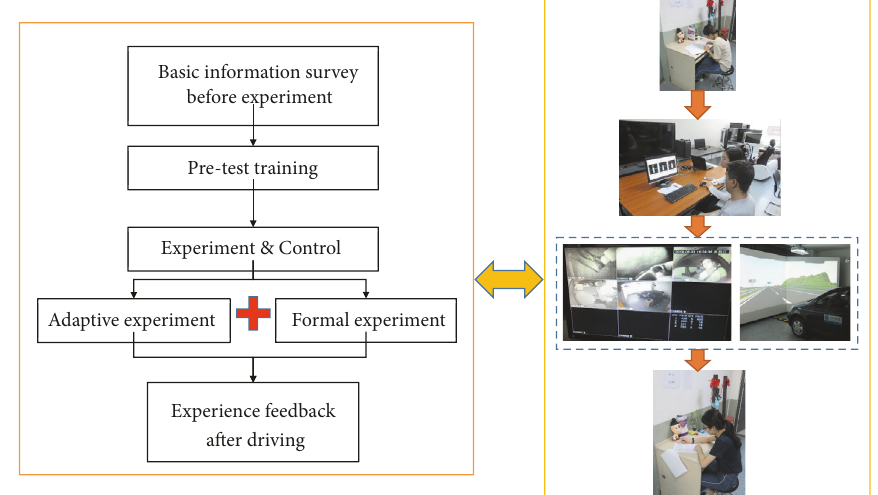
Figure 6: Experimental process.